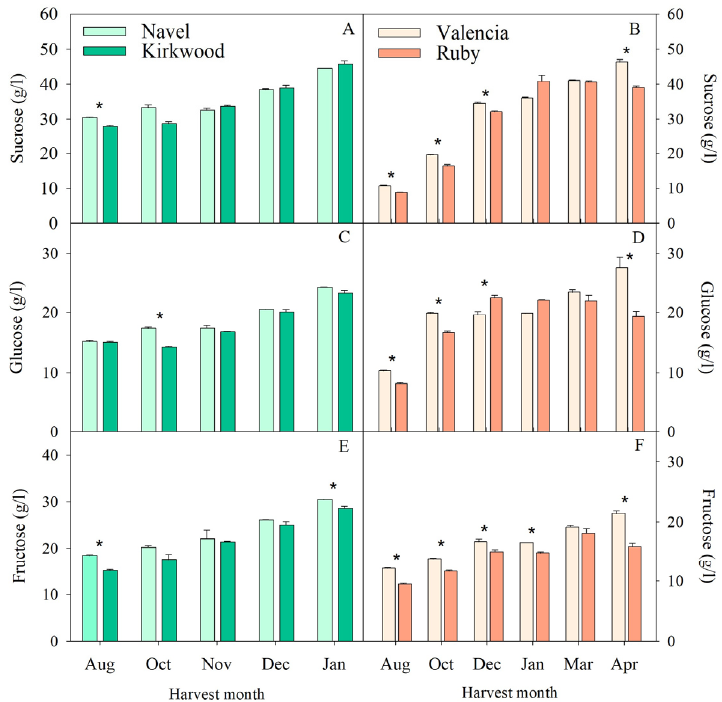
Figure 2. Concentrations of sucrose ( A , B ), glucose ( C , D ) and fructose ( E , F ) in the pulps of Navel and Kirkwood ( left panel ) and Valencia and Ruby ( right panel ) oranges during late fruit development and maturation. Results are the mean of two biological replicates ± SD. Asterisks indicate significant differences between the red-fleshed K and R and the respective ordinary oranges, N and V, for each harvest month by t -test ( p ≤ 0.05).